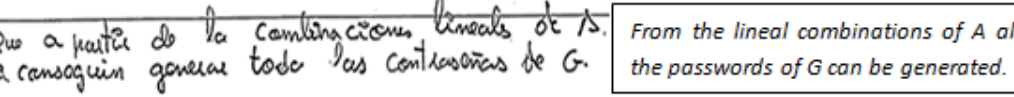
Figure 3. Example of an answer of part 1 of task